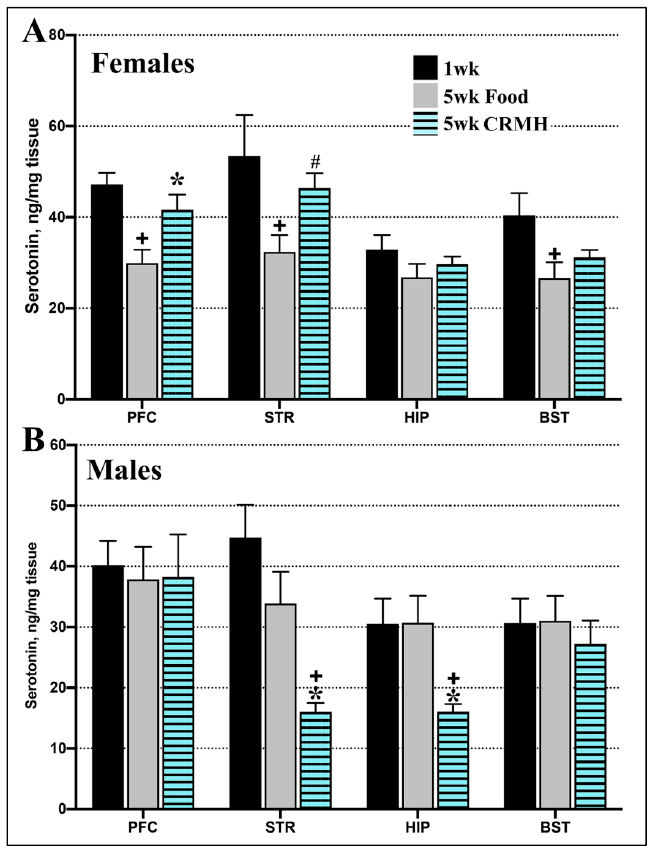
Figure 5. Dietary CRMH significantly increases brain serotonin levels in female rats at altitude but reduces brain serotonin in males at altitude. ( A ). In females, CRDS significantly increased serotonin levels in the PFC and STR vs. food controls but did not significantly change serotonin levels in the HIP or BST. In the female PFC and STR, the CRMH group was not significantly different from the 1 week altitude group. ( B ). In males, CRMH treatment significantly decreased serotonin in the STR and HIP, with no effects in the PFC or BST (one-way ANOVA, * = p <0.05 vs. food controls, + = p < 0.05 vs. 1 week altitude or baseline, # = p < 0.05).